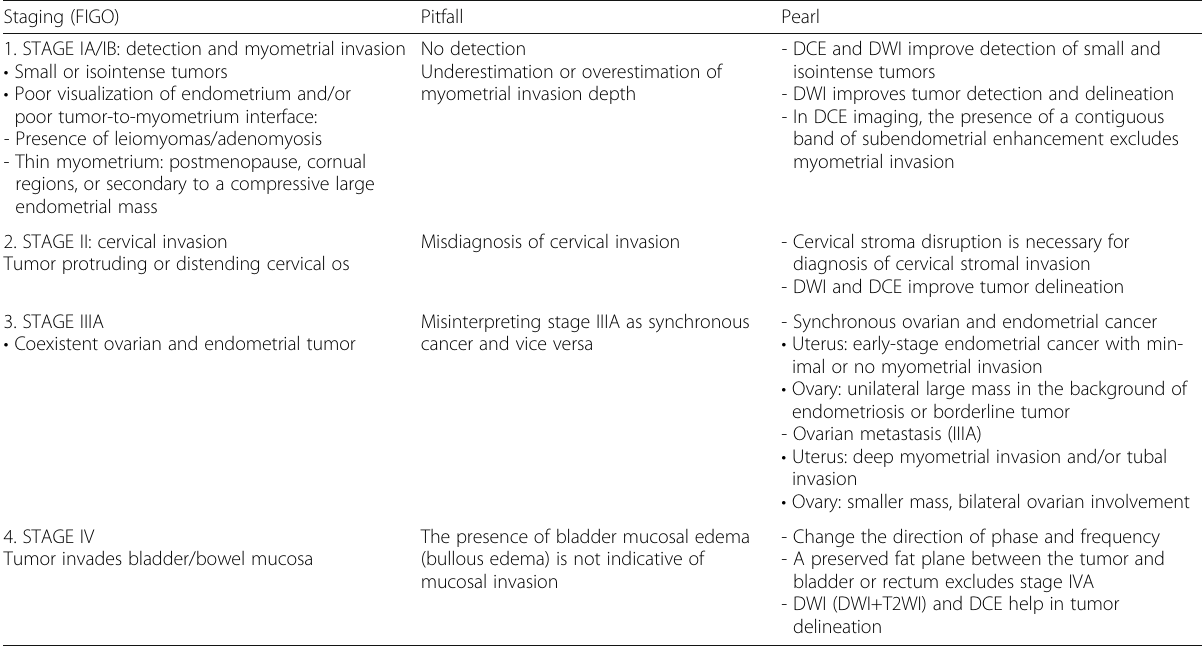
Table 5 MRI in endometrial cancer staging. Pitfalls and pearls Staging (FIGO) Pitfall Pearl